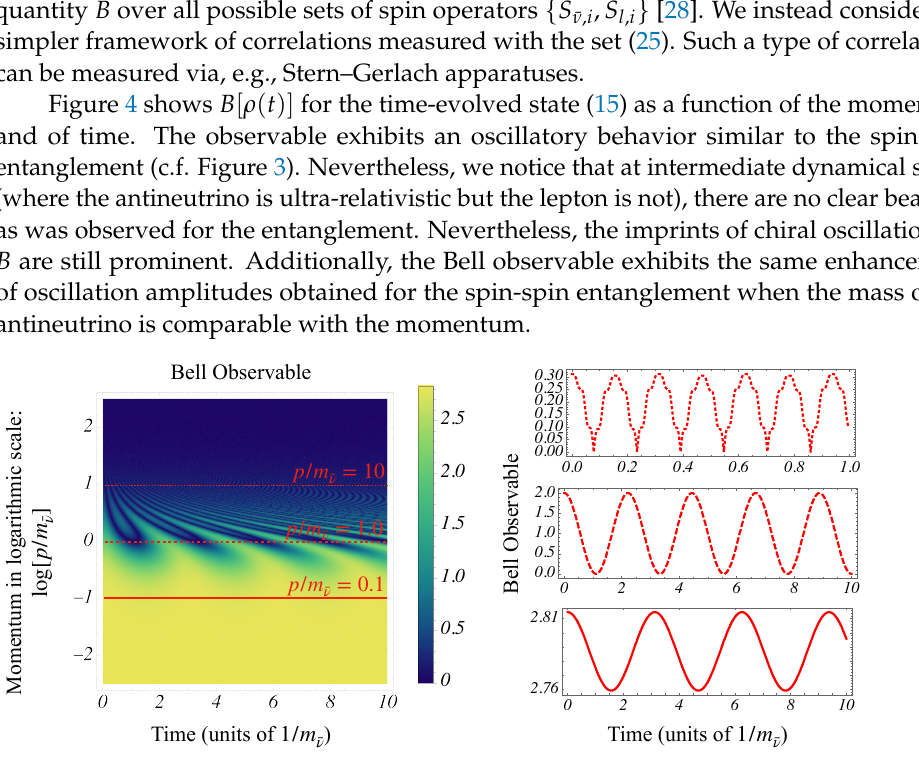
Figure 4. Bell observable (24) as a function of the momentum (in units of the antineutrino mass and in log scale) and of time for m l / m ¯ ν = 10 2